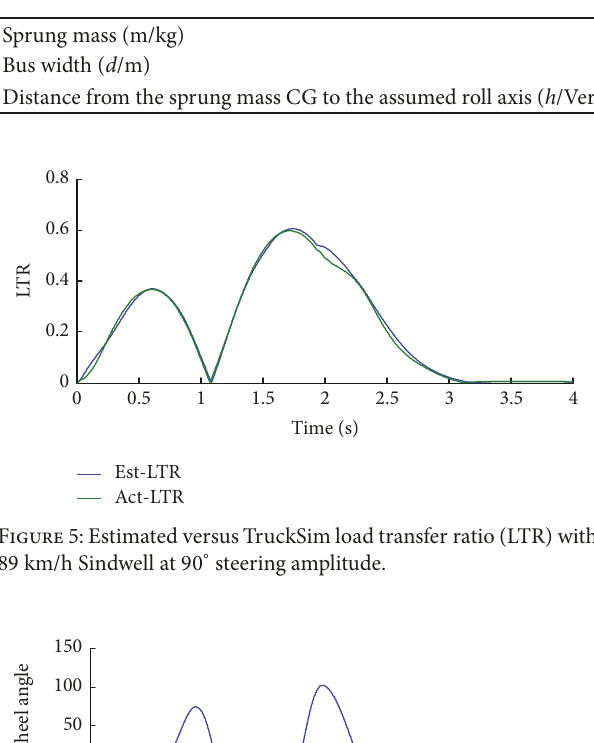
Table 1: Some parameters of the bus in TruckSim.